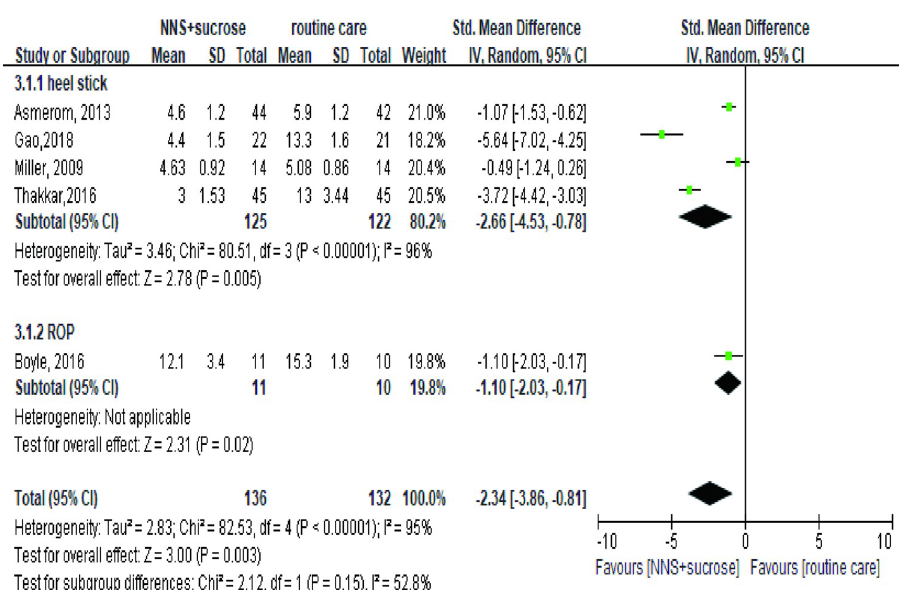
Fig 7. Forest plot of pain score comparing the combined intervention (NNS and sucrose) with routine care group during the procedures. NNS: nonnutritive sucking. https://doi.org/10.1371/journal.pone.0268033.g007 3.2.5 NNS+OS versus glucose. Only one study enrolling 66 term newborns set glucose +NNS as the control group [48].The result demonstrated a significant difference (p < 0.05) in both two phases. NIPS scores were significantly lower in the NNS+sucrose group (range 1–2 and median 0) compared with the NNS+glucose group (range 5–7 and median 6) during venipuncture. 3.2.6 Publication bias. Publication bias was tested by Egger’s Test and funnel plots (Fig 9A, 9B). The results of Egger’s test indicated no publication bias in both scenarios. The bias